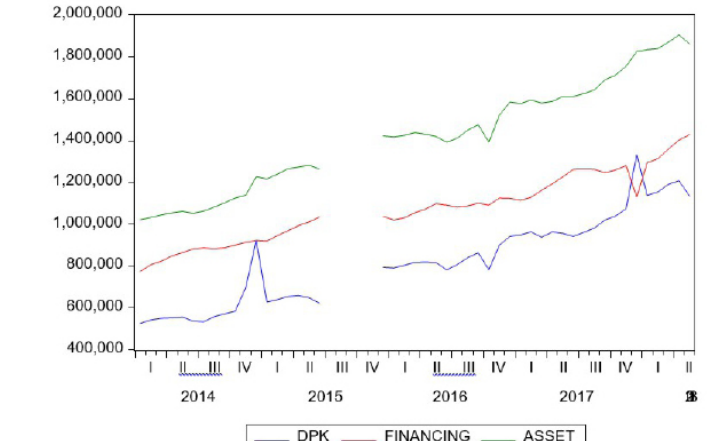
Figure 2: Growth in BPRS Total Deposits, Total Financing and Total Assets in East Java Prov- Source: Data Processed (2018)